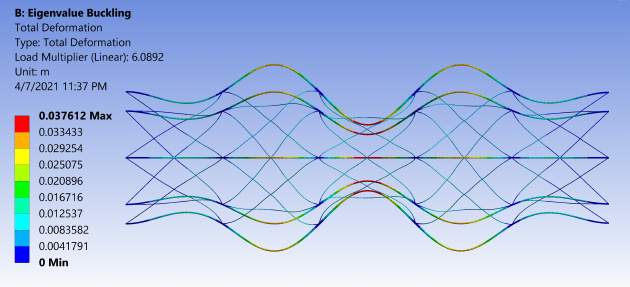
Figure 18. Local buckling of Set 2 OLC with two carbon tows in helical members [26].